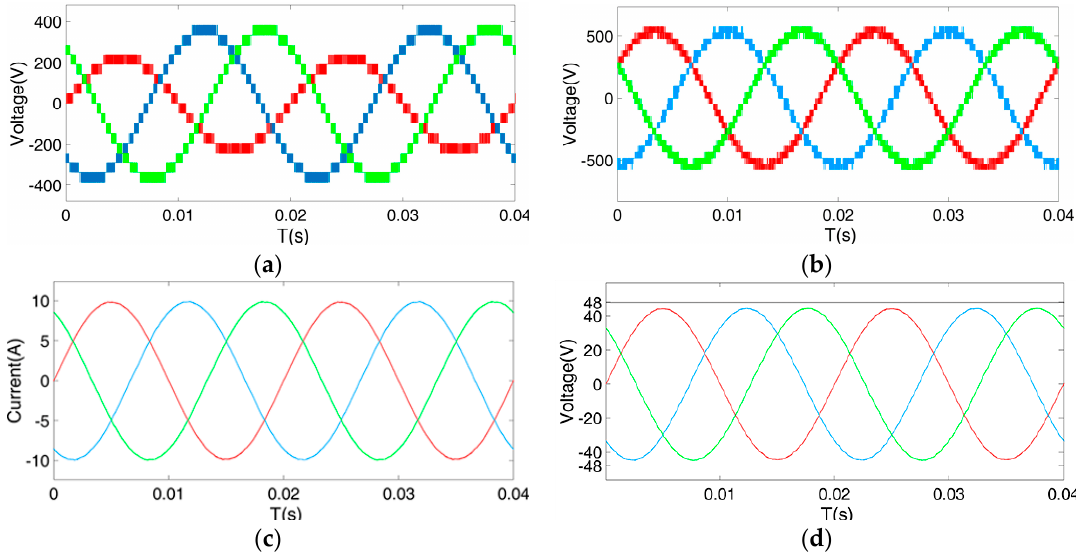
Figure 7. Waveforms for the “588” operation state with fundamental phase shift compensation (FPSC): the ( a ) three-phase converter output voltage; ( b ) three-phase line-to-line voltages; ( c ) grid current; ( d ) three-phase sub-module modulating waveform.